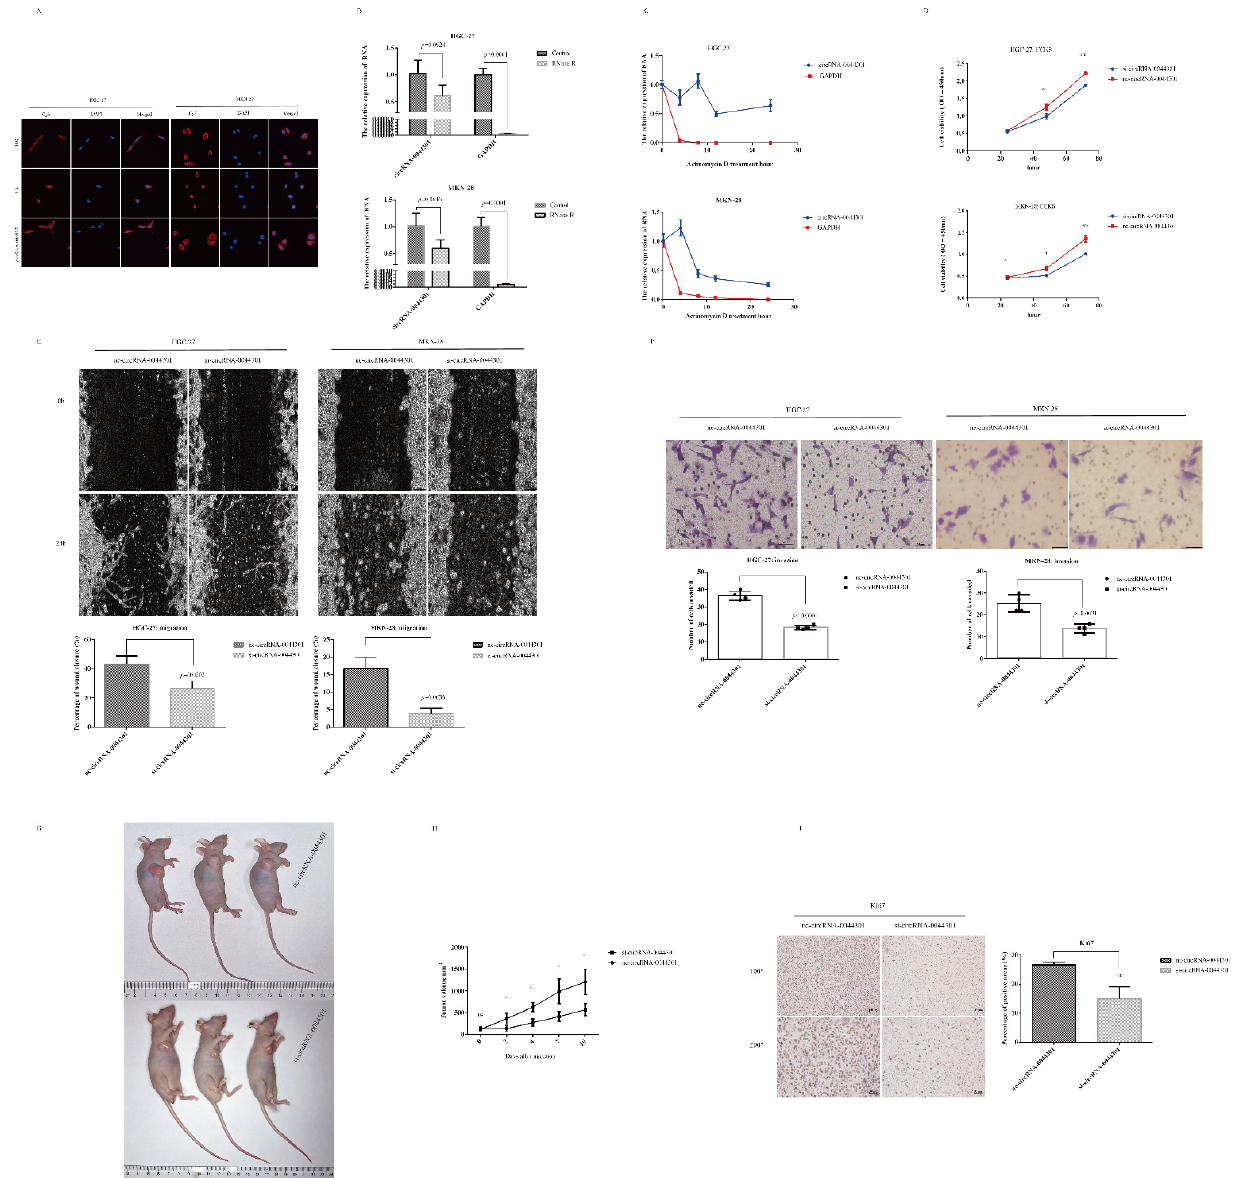
Figure 5. The characteristics and function of circRNA-0044301 on cells in vitro and in vivo . ( A ) FISH assay to detect the subcellular localization of circRNA-0044301 in HGC-27 and MKN-28 (The samples were imaged at 60× magnification). ( B ) RNase R treatment to determine the circular nature of circRNA-0044301 in GC cell lines. ( C ) Actinomycin D assay to explore the half-life of circRNA-0044301 and linear RNA in HGC-27 and MKN-28. ( D ) CCK-8 assay for the viability of HGC-27 cells (top) and MKN-28 cells (bottom) in the si-circRNA-0044301 group and nc-circRNA-0044301 group (***: p < 0.001; **: p < 0.01; *: p < 0.05; ns: no difference). ( E ) Wound healing assay for the cell migration ability of GC cells after circRNA-0044301 knockdown over time (0 h and 24 h), and the percentage of wound closure was statistically analyzed (The samples were imaged at 100× magnification. Scale bar = 100 µm). ( F ) Results of the Transwell assay of HGC-27 cells (top) and MKN-28 cells (bottom) transfected with si-circRNA-0044301 and nc-circRNA-0044301 (the samples were imaged at 200× magnification. Scale bar = 50 µm). ( G ) Subcutaneous tumorigenesis model, specific siRNA transfection was adopted to reduce circRNA-0044301 levels in tumors. ( H ) The size of tumor volume was measured in vivo every 2–3 days using Vernier caliper (*: p < 0.05; ns: no difference); ( I ) IHC assay demonstrated the level of Ki67 in control siRNA and specific siRNA-treated groups (**: p < 0.01).